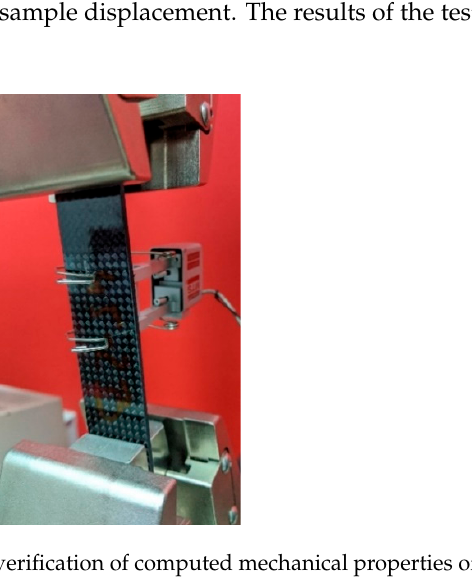
Table 2. Orthotropic mechanical properties of a single ply and laminates.